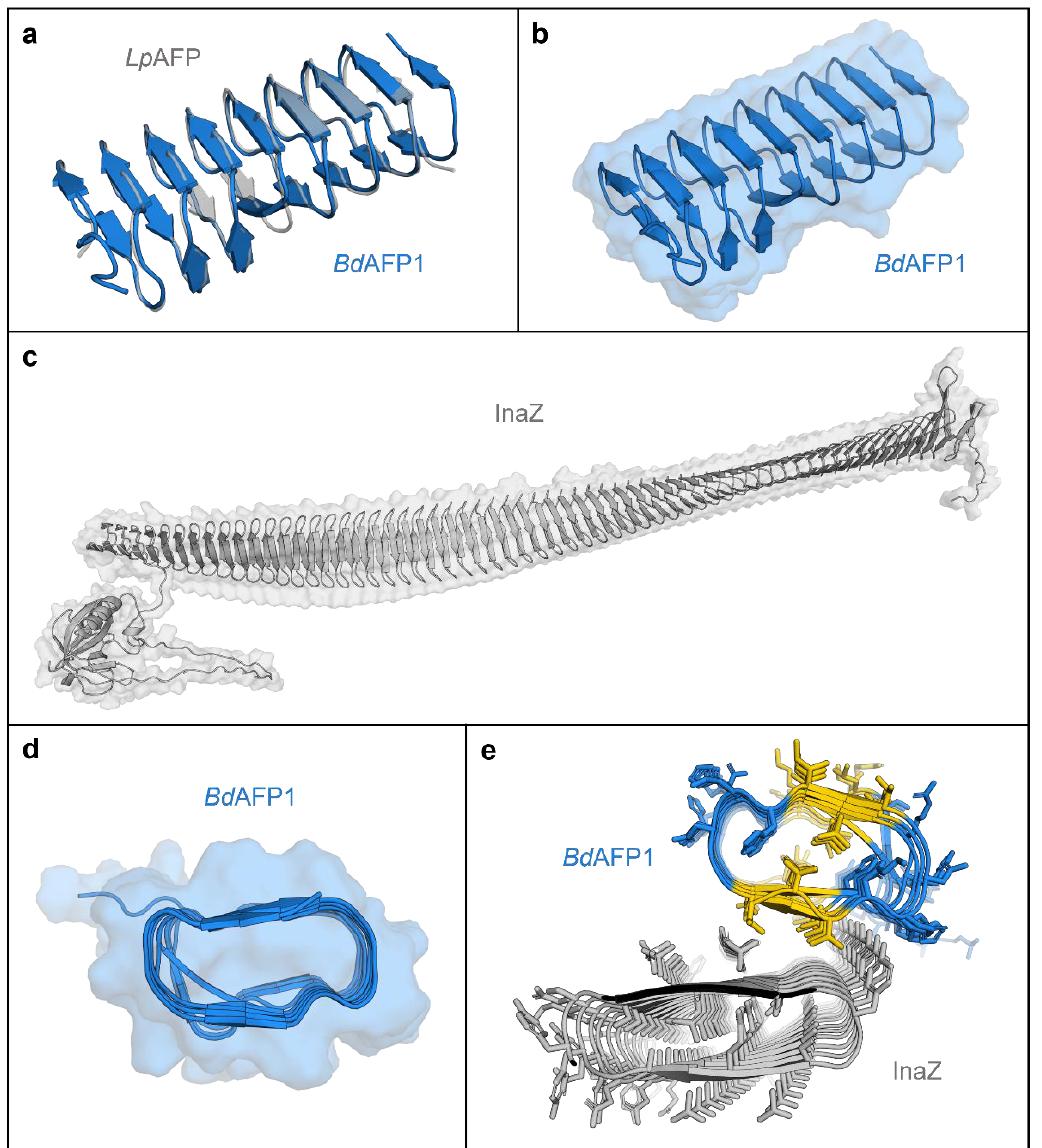
Figure 2. AlphaFold models of Brachypodium distachyon antifreeze protein (AFP) based on the representative BdIRI1 AFP and Pseudomonas syringae ice nucleating protein (INP) and their interactions as predicted with FRODOCK. ( a ) AlphaFold Bd AFP model (in blue) shown aligned to the crystal structure of the related Lp AFP (PDB ID: 3ULT; in grey). ( b ) AlphaFold Bd AFP beta-solenoid fold with the solvent-accessible surface shown in transparency and with both ice-binding surfaces depicted as flat ribbons (with the “ a- and b-faces ” on the upper and lower surfaces, respectively, with residues detailed in Figure S4). ( c ) AlphaFold model of P. syringae INP as a twisted right-handed solenoid formed from the repetitive sequences with the N-terminal membrane anchor to the left, the cap sequence on the right, and the solvent-accessible surface area shown in transparency. ( d ) Bd AFP cross section demonstrating the hydrophobic internal core and showing the relatively flat surface contours created by the ice-binding motifs, with the “ a-face ” shown on the upper side. ( e ) Cross section of a FRODOCK docking prediction of interactions between Bd AFP (from BdIRI1 AFP) in blue with the ice-binding faces in yellow (with the AFP “ a-face ” , closest to the INP), and P. syringae INP with two water-organising faces (with the INP “ a-face ” upwards, closest to the AFP). Note: The top 10 FRODOCK predictions (encompassing scores from 7212 down to 6349 as shown in Figure S5) show AFP binding along the entire length of the “a-face” of the INP via the “a-face” of the AFP, with only a representative image shown